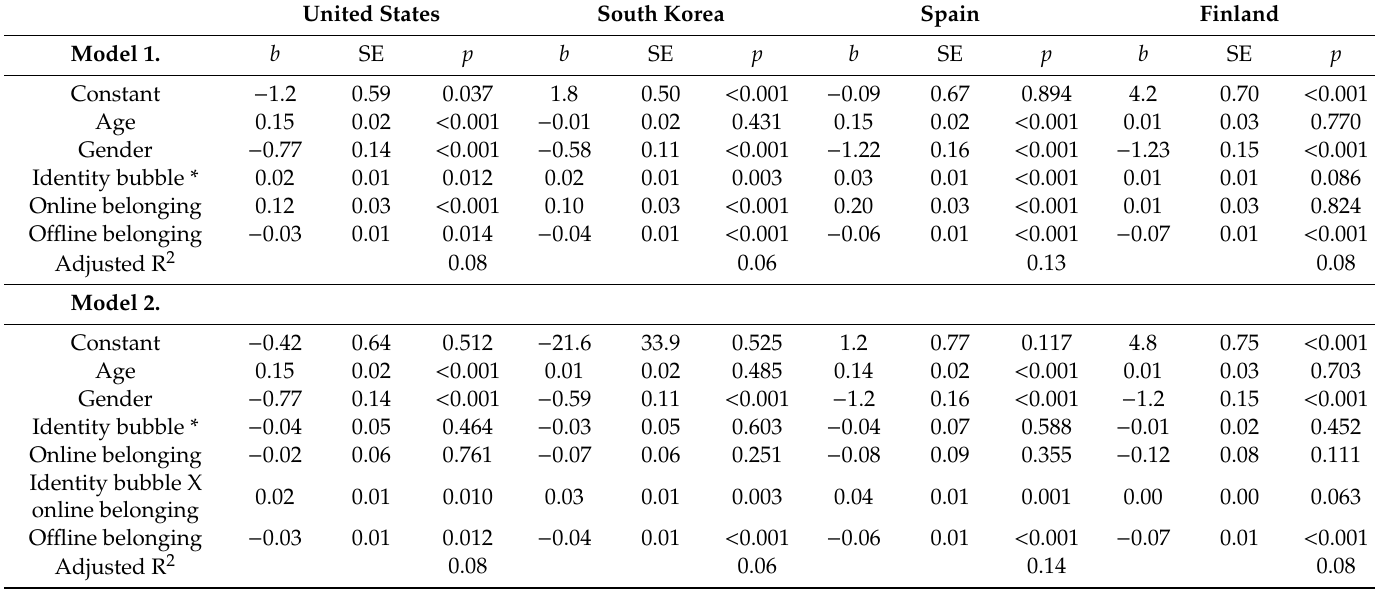
Table 3. Linear Regression Models Predicting Problem Gambling from Social Media Identity Bubble Involvement in Four Countries. United States South